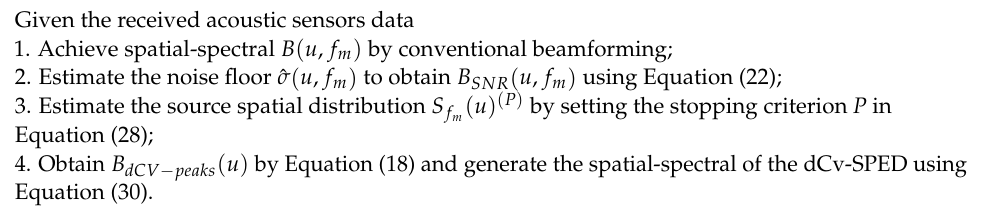
Algorithm 1. Summary of the dCv-SPED beamforming